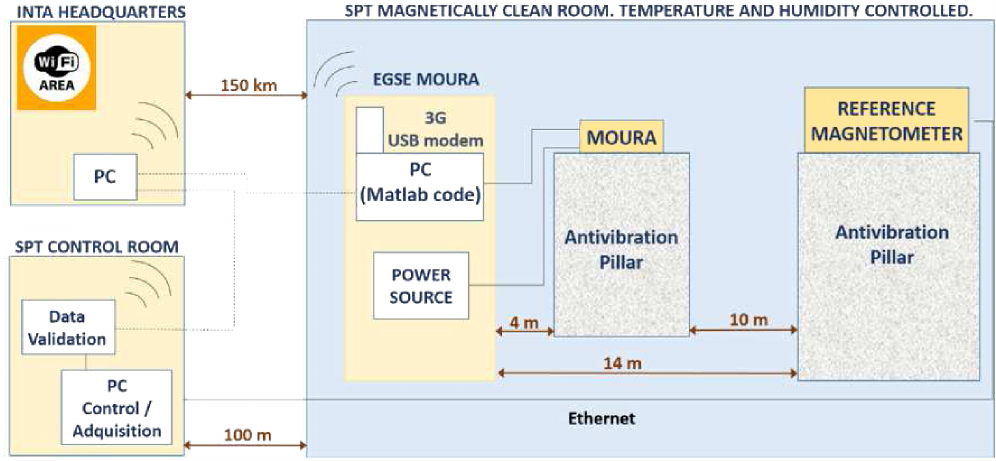
Figure 13. Setup of the